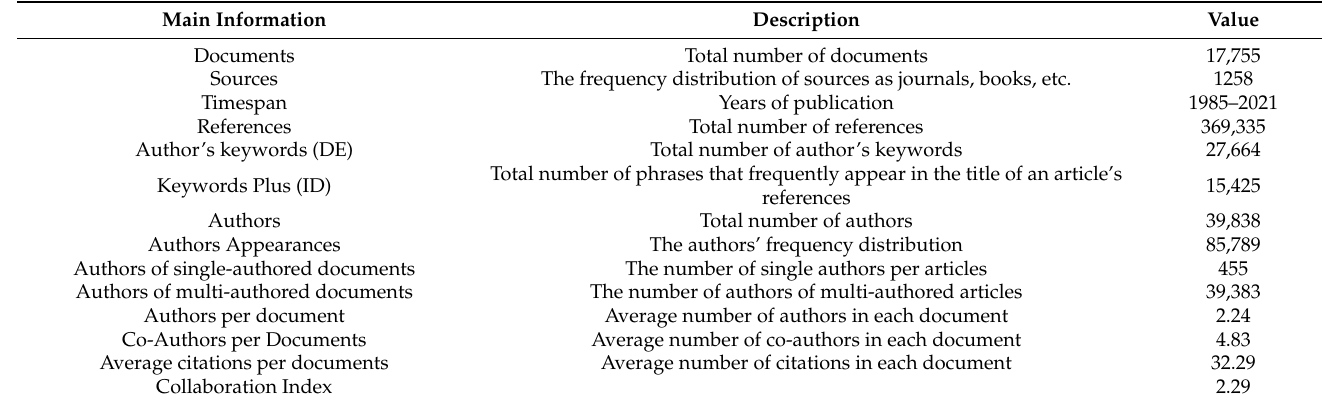
Table 2. Key information of NDVI-related literature identified by the bibliometric analysis.